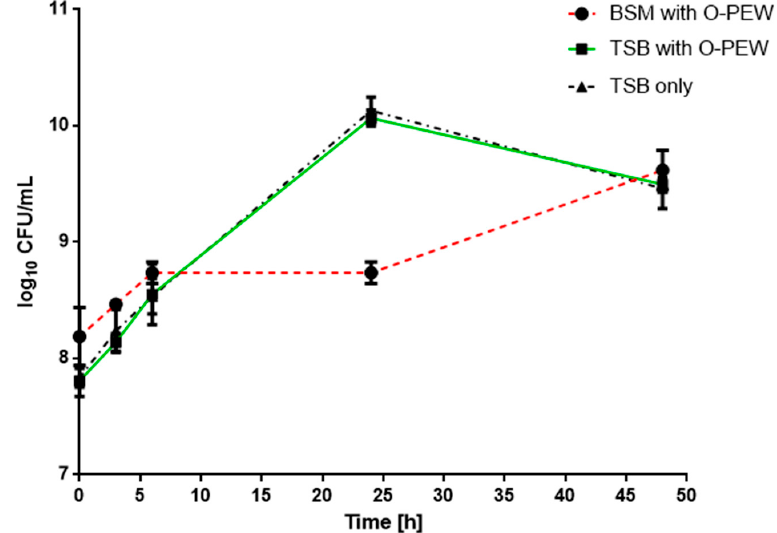
Figure 2. Small-scale shake-flasks experiments of R. eutropha H16 with 5 g/L of O-PEW in TSB (green line, black squares) or BSM (red line, black circles) and TSB only (black line, black triangles). Viable count (log 10 CFU/mL) data points at time 0, 3, 6, 24, and 48 h are the arithmetic means of triplicates, while error bars represent the standard error (SE) of the mean.